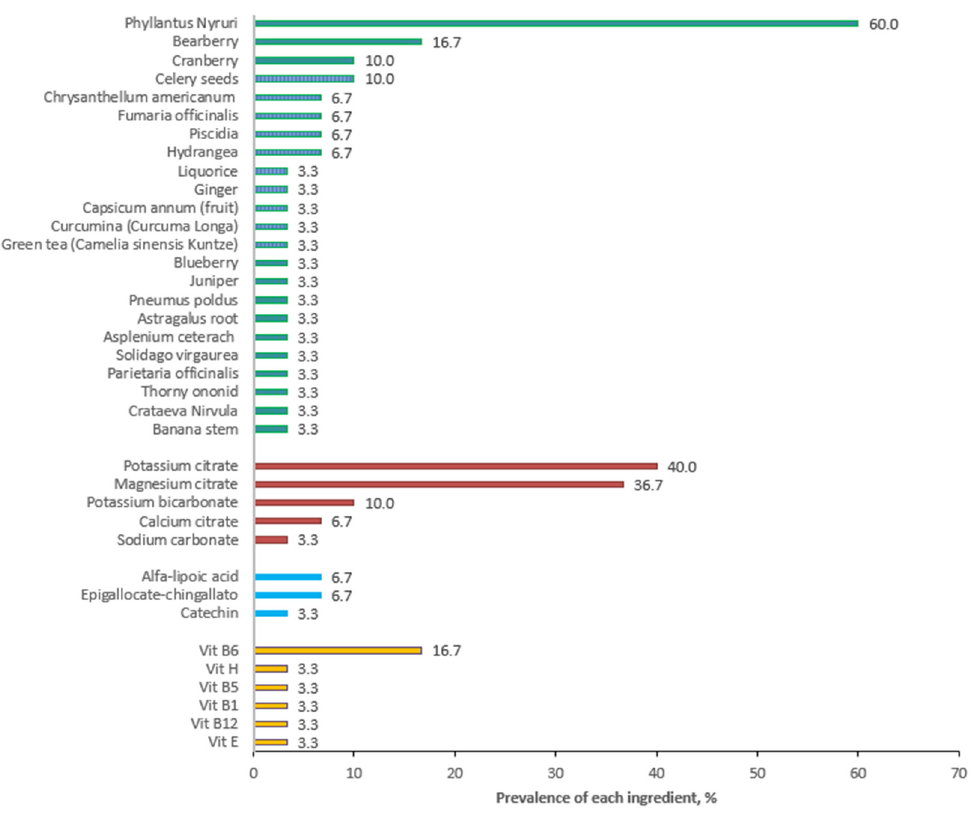
Figure 2. Prevalence of various ingredients in 30 products available on the market and claiming to treat kidney stones. Data are expressed as a percentage.